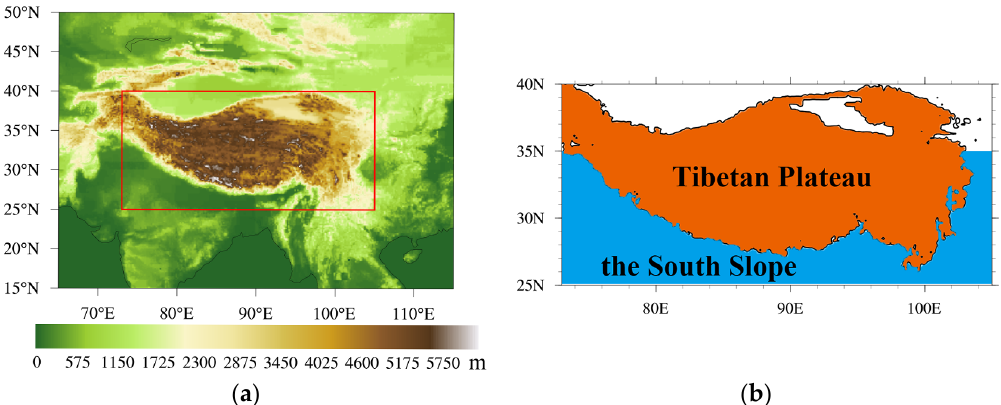
Figure 1. ( a ) Topography of the study area, with the red rectangle showing the location of the study region (25–40° N, 73–105° E). ( b ) The two sub-regions of the Tibetan Plateau and its southern slope. The black line represents the 3000 m elevation contour.